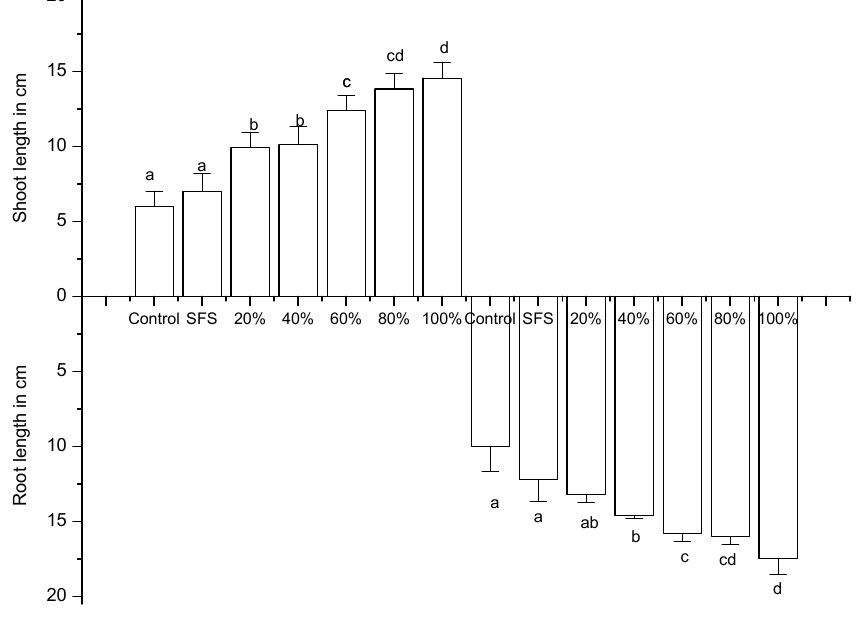
Figure 14. E ff ect of EF-LSE on root-shoot lengths of tomato Figure 14. Effect of EF-LSE on root-shoot lengths of tomato plants.